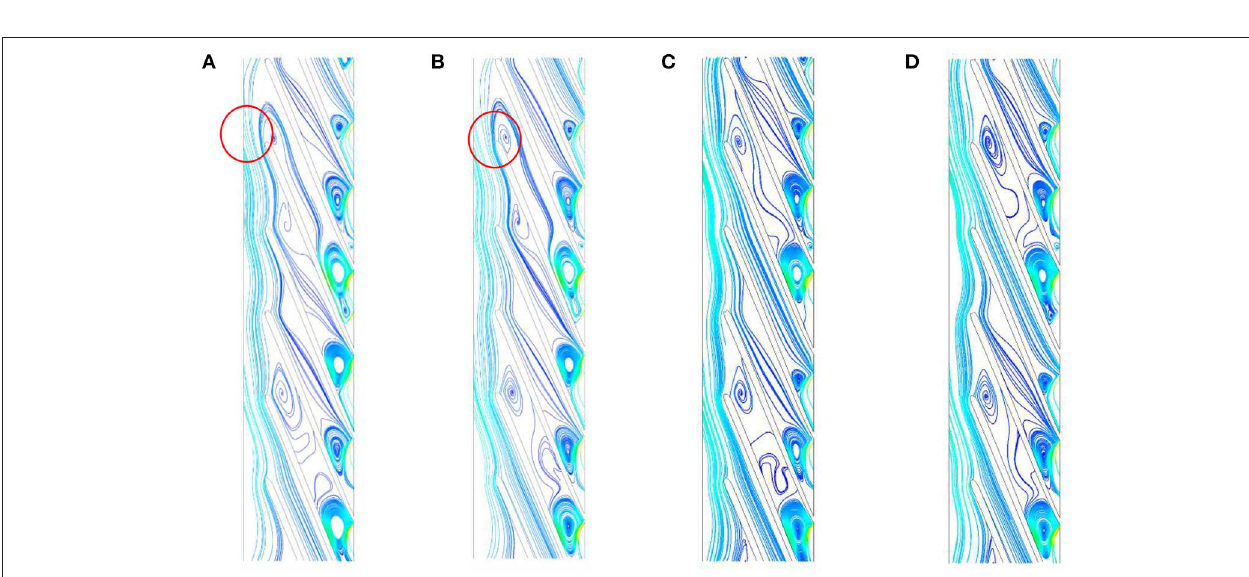
FIGURE 17 | Streamline distribution among blades with different flow rates under steady state of equal flow rate. (A) Q = 8.01 m 3 /h, (B) Q = 11.39 m 3 /h, (C) Q = 17.48 m 3 /h, and (D) Q = 20.33 m 3 /h.